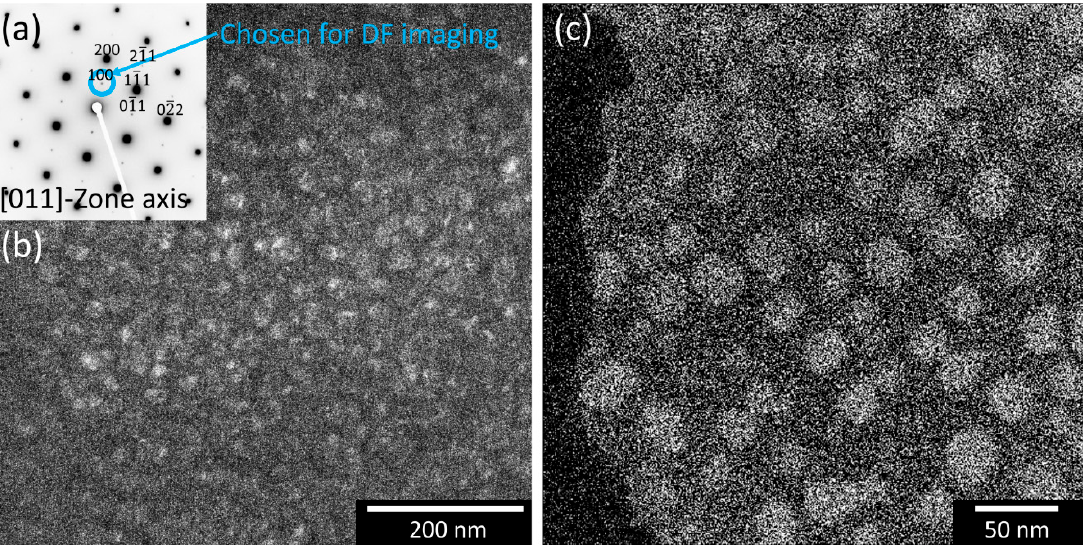
Figure 2. SAD ( a ), TEM DF image ( b ), and EFTEM image for Al ( c ) of the alloy after 50 h of aging. The presence of γ ’ precipitates can be seen.